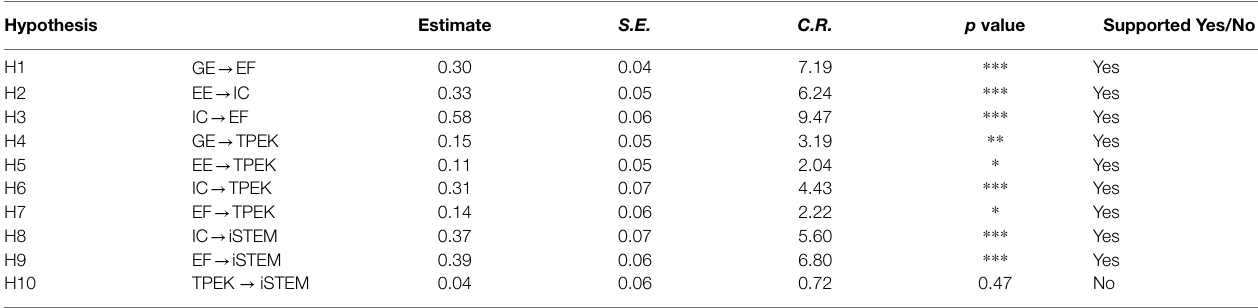
TABLE 3 | Hypothesis